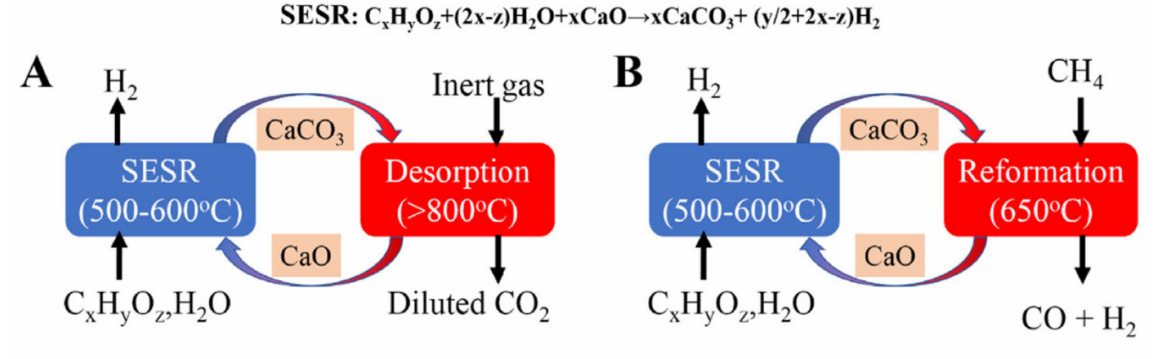
Figure 8. Scheme of ( A ) conventional process of the cyclic SESR, and ( B ) coupled process of SESR-CH 4 reforming operation. (Reprinted with permission from [84]. 2021, Dang et